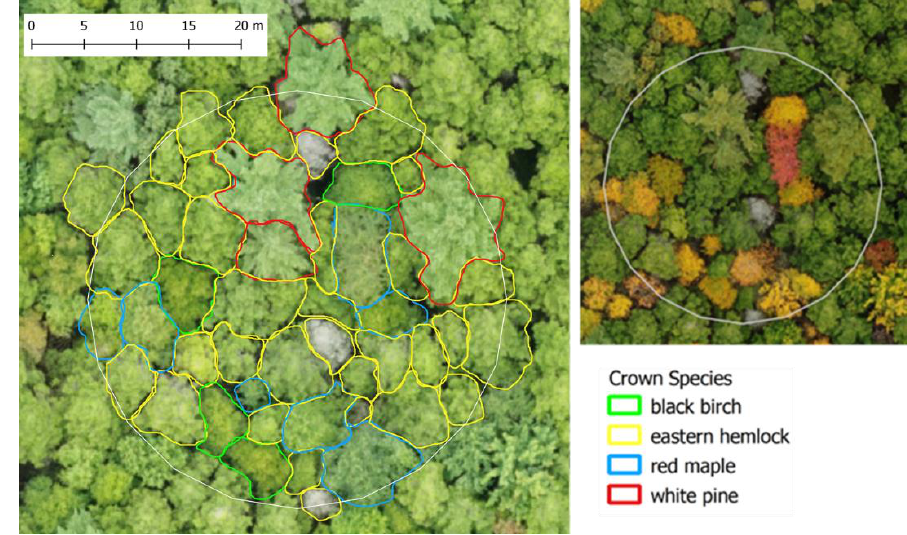
Figure 1. Manual crown delineation was performed using 2018 high resolution UAV imagery. All delineations were done on the September 13 th image (left panel), but other dates of imagery were used to help differentiate crowns growing in close proximity. The right panel (October 12 th ) gives an example of phenologic differences between species that can be leveraged to help separate crowns that might otherwise be clumped during manual interpretation.